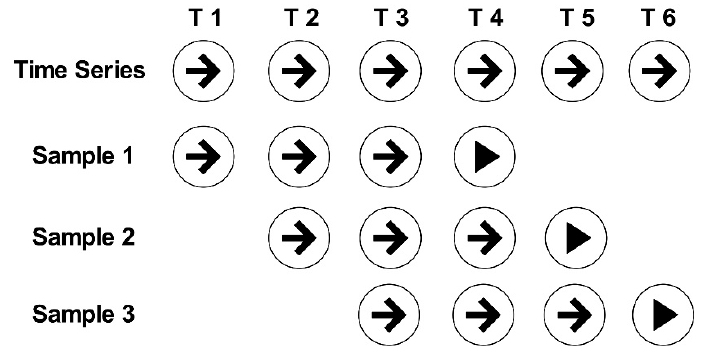
Figure 6. An example of constructing time series samples by sliding window.